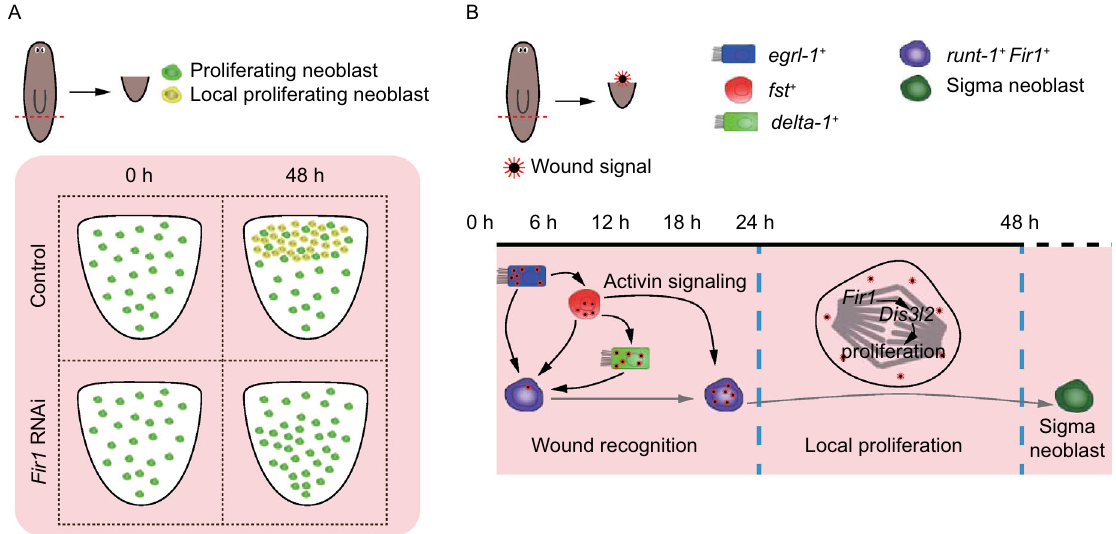
Figure 8. Model of Fir1 mechanisms in regeneration. (A) Model of Fir1 function in regeneration. Fir1 , a neoblast-enriched regulator, controls regenerative proliferation. (B) A proposed genetic model for Fir1 in regeneration. Once a missing-tissue injury occurs, Fir1 + cells at the wound sites acquire wound and regenerative signal, sense regeneration on demand. Then Fir1 promotes the expression of Dis3l2 , which triggers local proliferation, and generate suf fi cient neoblast for sequential